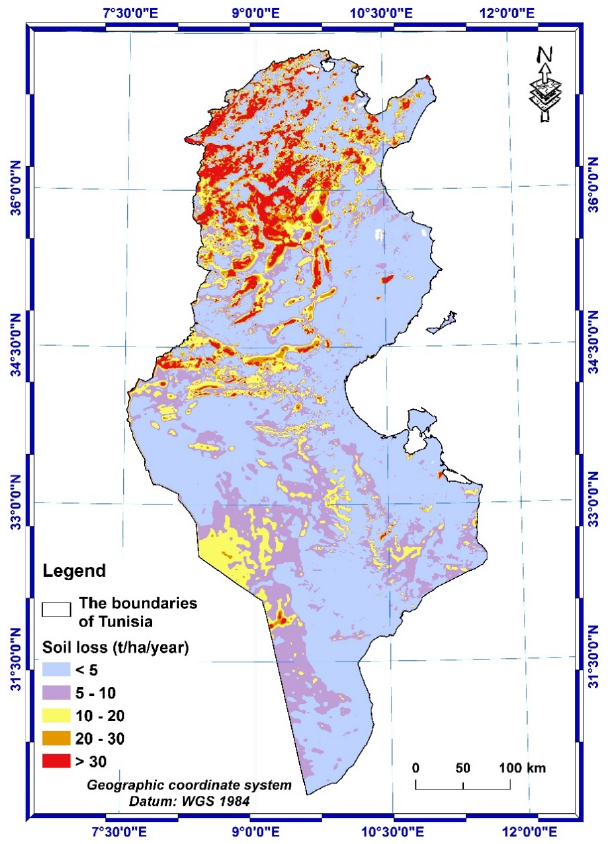
Figure 15. Soil loss map in Tunisia.